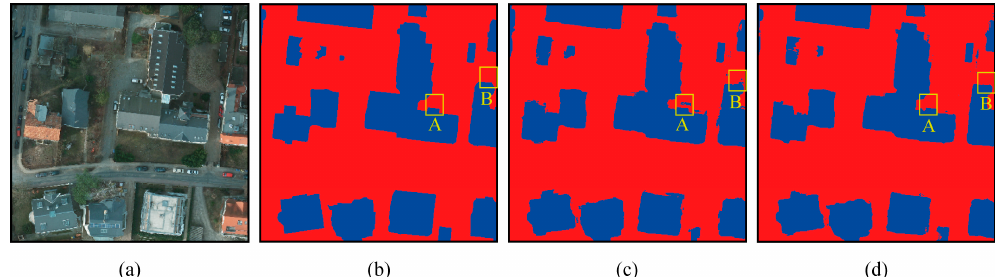
Figure 8. Results of the building extraction in the urban district of the Potsdam dataset with and without edge enhancing preprocessing. ( a ) The original imagery of this urban district. ( b ) The ground truth of this region. ( c ) The prediction results using the Res-U-Net without enhanced preprocessing. ( d ) The prediction results with enhanced preprocessing.